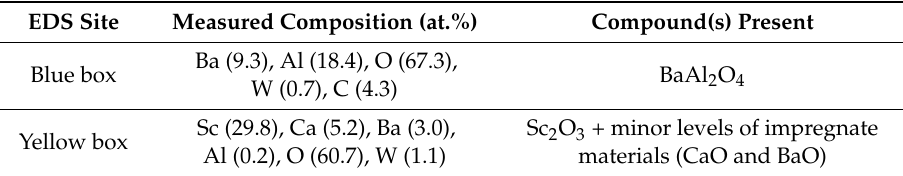
Table 1. Quantified measurement of particle composition, obtained from EDS point analysis of the regions marked in Figure 6.